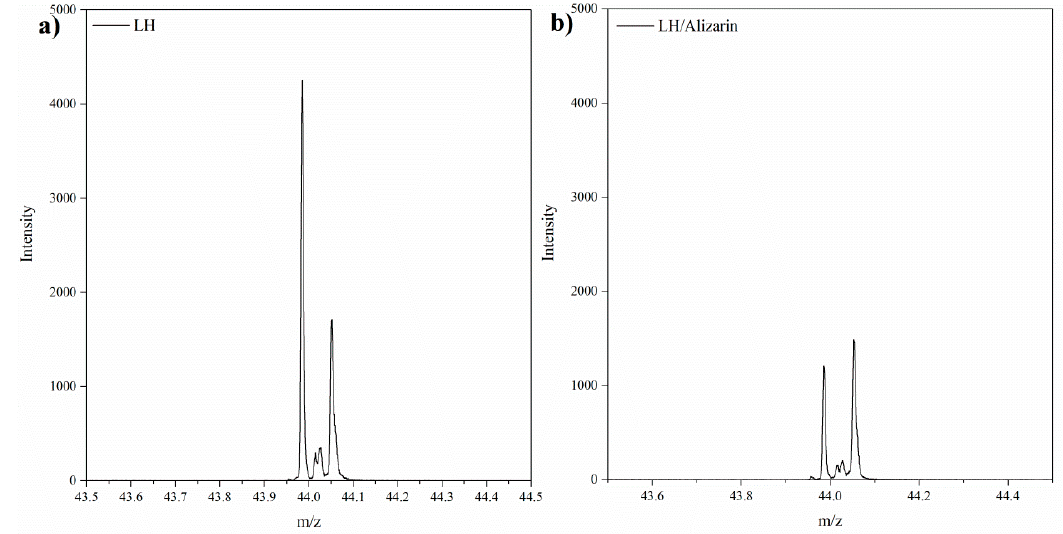
− ions in LH ( a ) and LH/Alizarin (10%) ( b 2